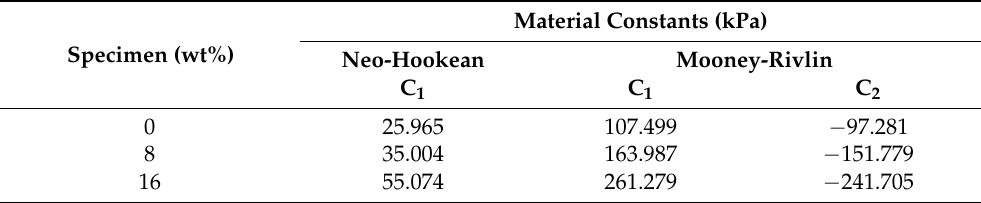
Table 1. Neo-Hookean and Mooney–Rivlin Material Constants (kPa) for specimens without being immersed in seawater.